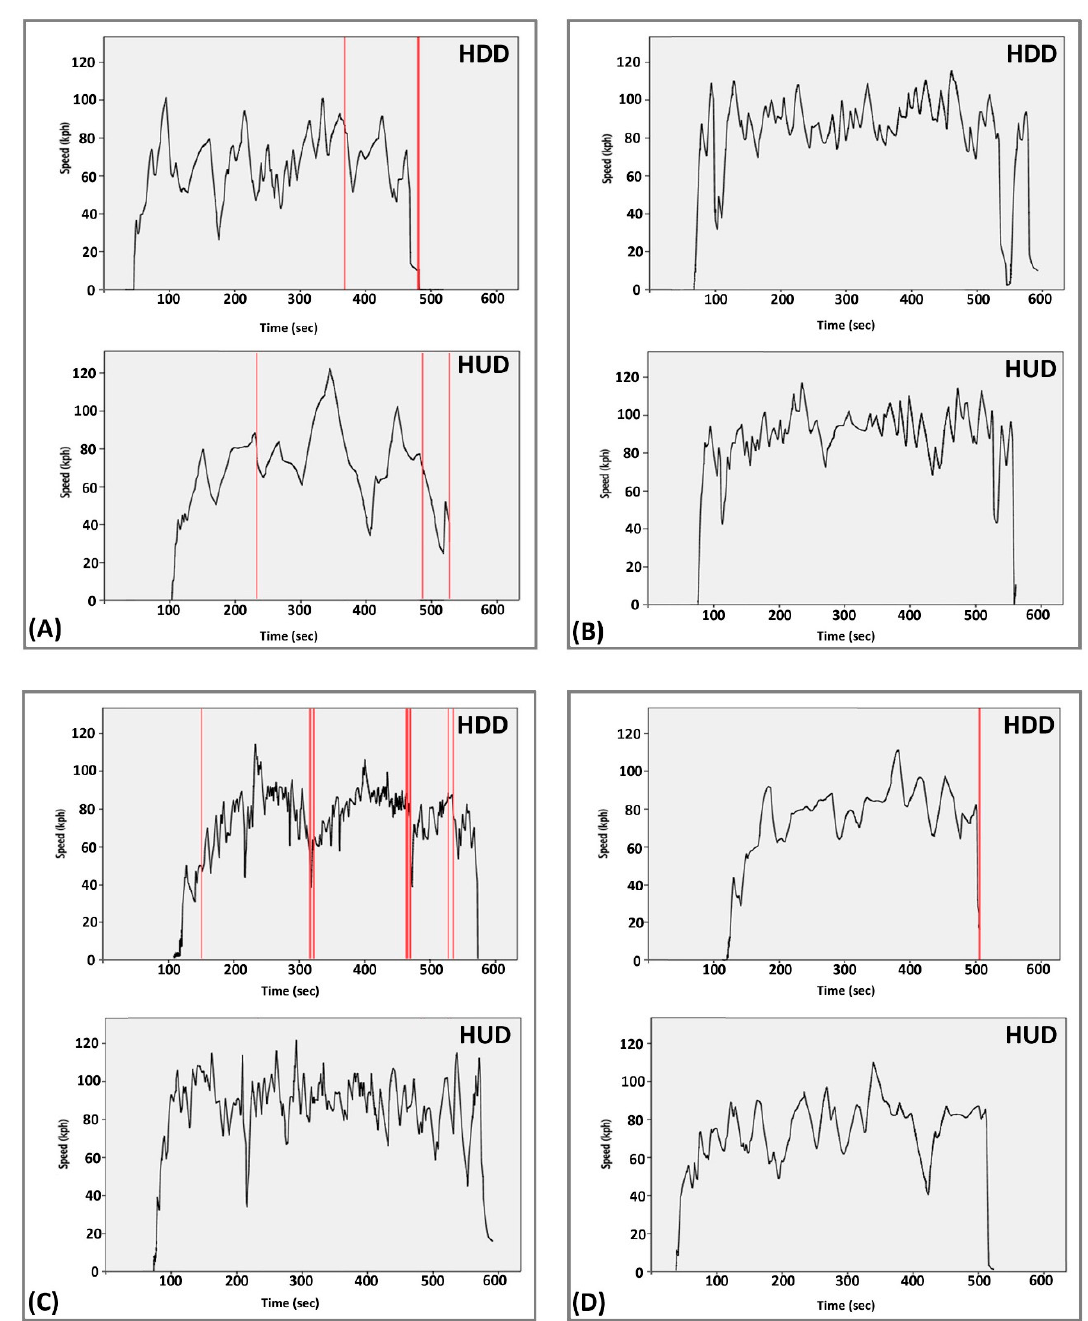
Figure 15. Four indicative driving patterns defined by the collisions occurred with the use of HUD and HDD: ( A ) collision with HUD and with HDD, ( B ) no collisions with HUD and no collisions with HDD, ( C ) large number of collisions with the use of HDD, and ( D ) no collisions with HUD and collisions with HDD.